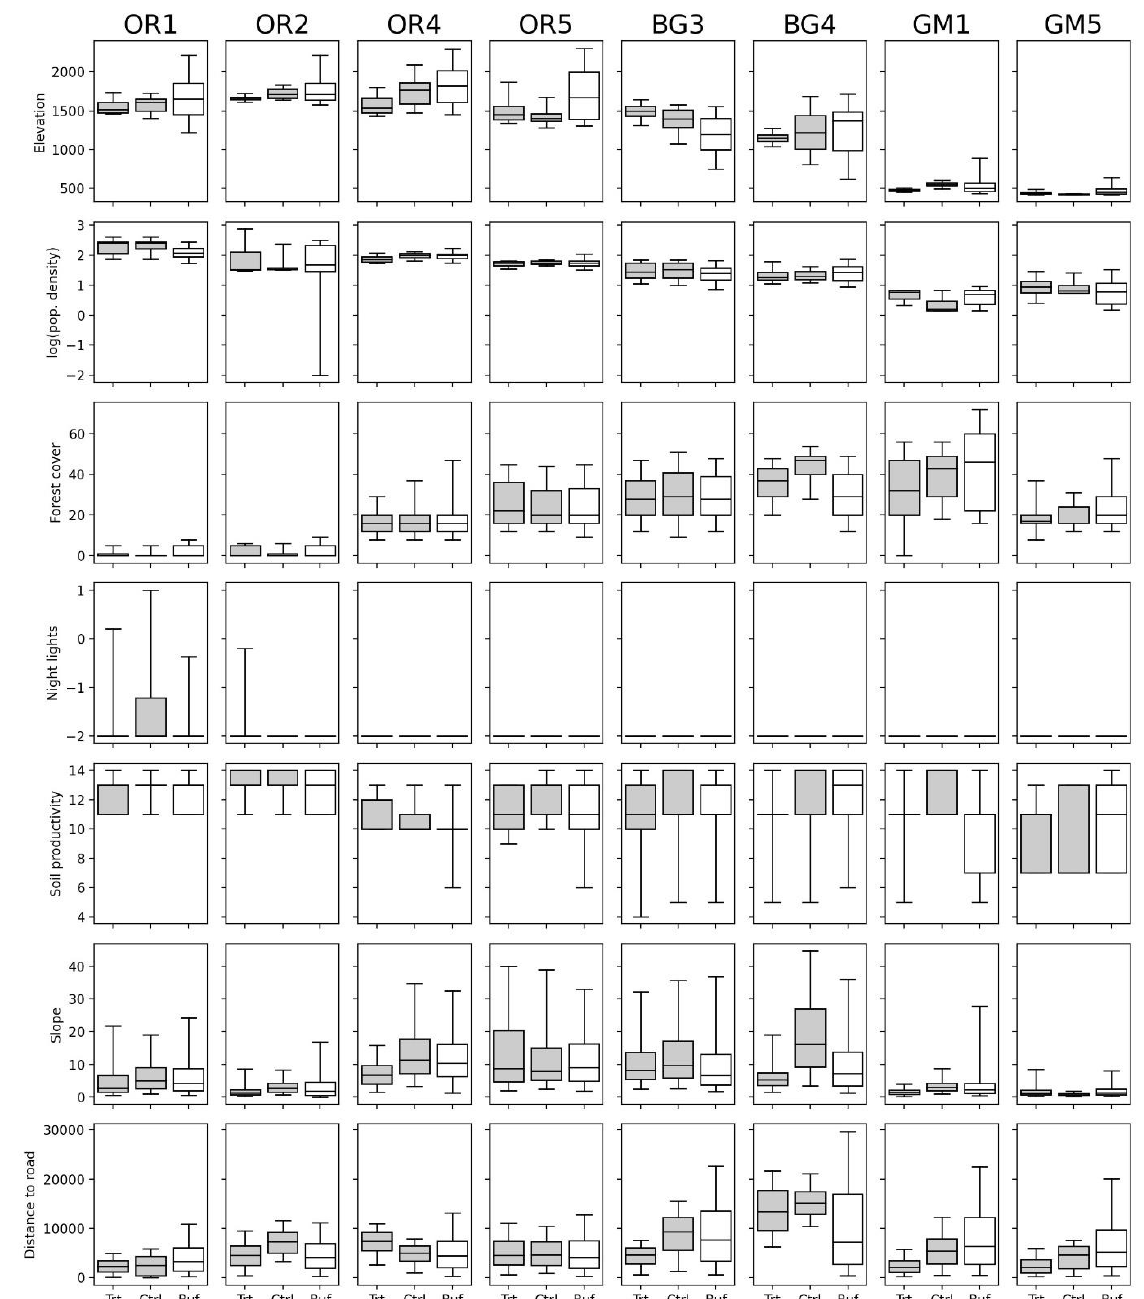
Fig. A4.2: Boxplots of the covariate distributions in each Treatment site, selected Control site, and 30km buffer from which the Control site was selected. The whiskers represent 5% and 95% percentiles of the data. Outliers are not shown. Note that the first stage only used four of these covariates (elevation, population, density, forest cover, and night lights) and the second stage used five (population density, forest cover, soil productivity, slope, and distance to